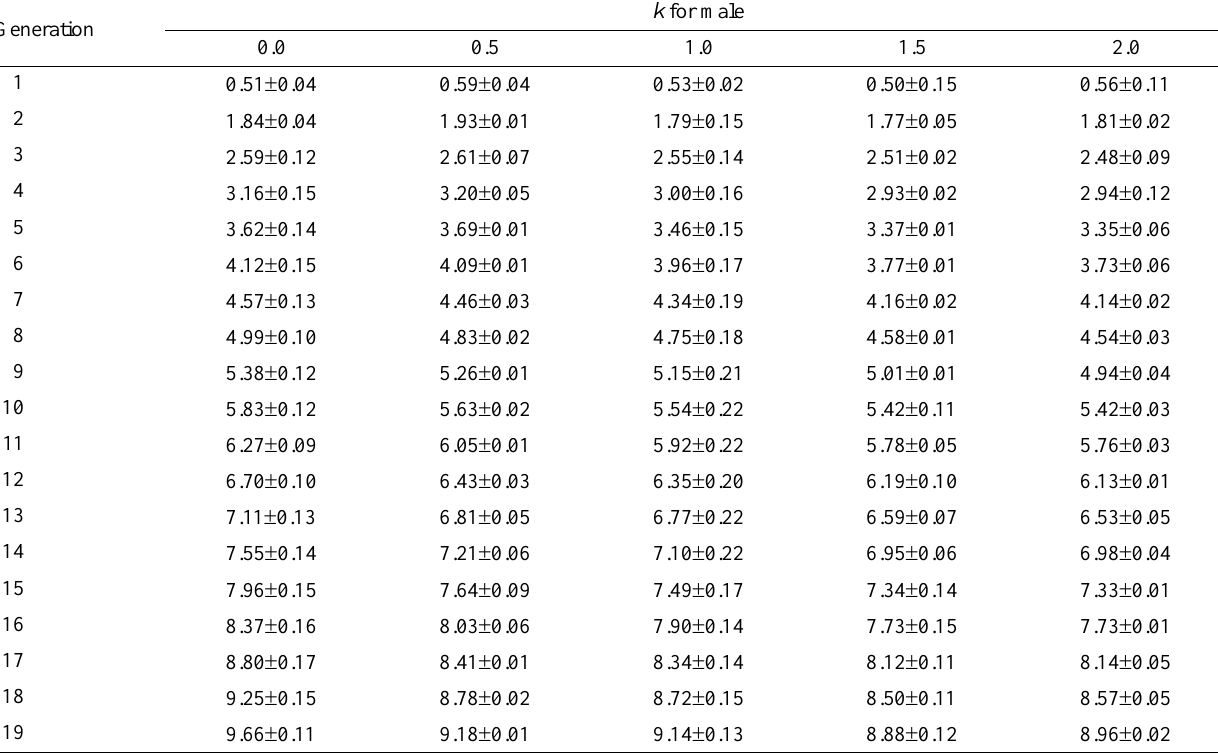
Table 5. Changes of average breeding values and standard deviations in female with different k values for male when k for female = 0 k for male Generation 0.0